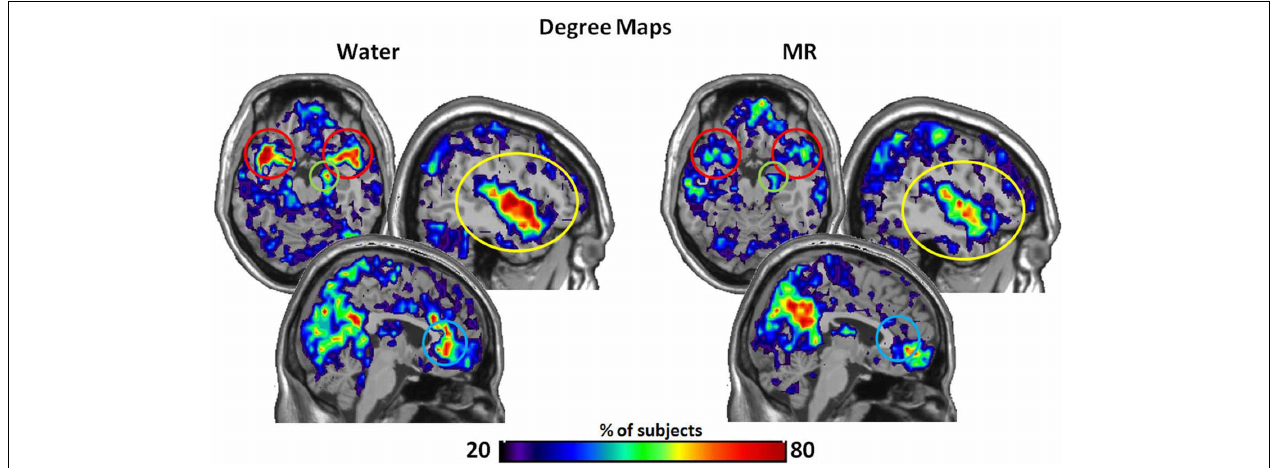
FIGURE 2 | The maps demonstrate brain areas found to consistently have high degree (i.e. number of connections). For each subject, the voxels with degree values in the top 20% were identified. The maps shown here represent the overlap of these voxels across subjects in each condition. The consistency of overlap between conditions is indicated by the color bar which represents thepercentageofindividualsforwhicheachvoxelwasamongthetop20%.On thetopleftareaxialslices(MNI z = 54) throughthesuperior temporal poleand